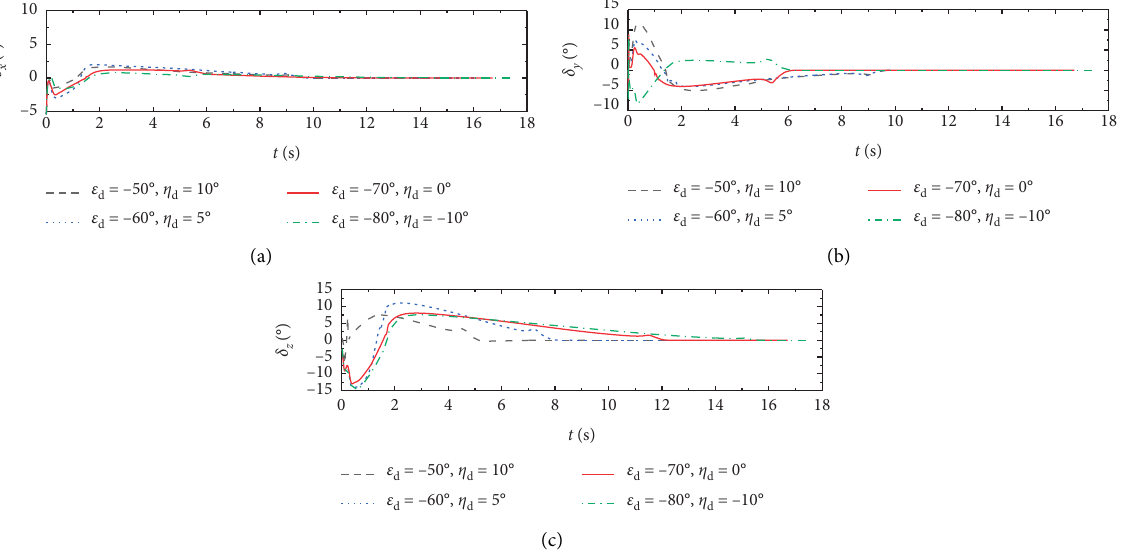
Figure 6: Curves representing rudder deflection angles of Case 1.